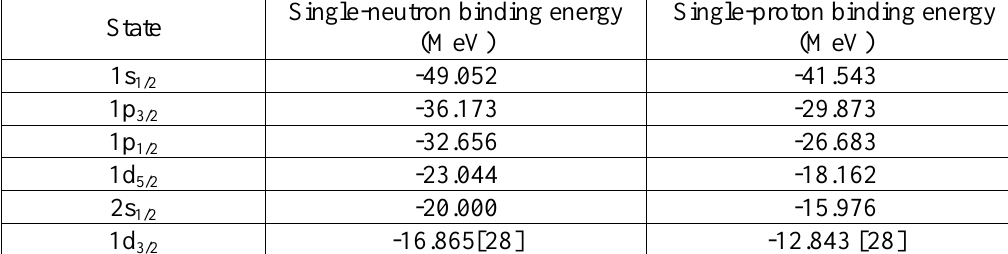
Table 6: Single-nucleon binding energies for 20 Ne.